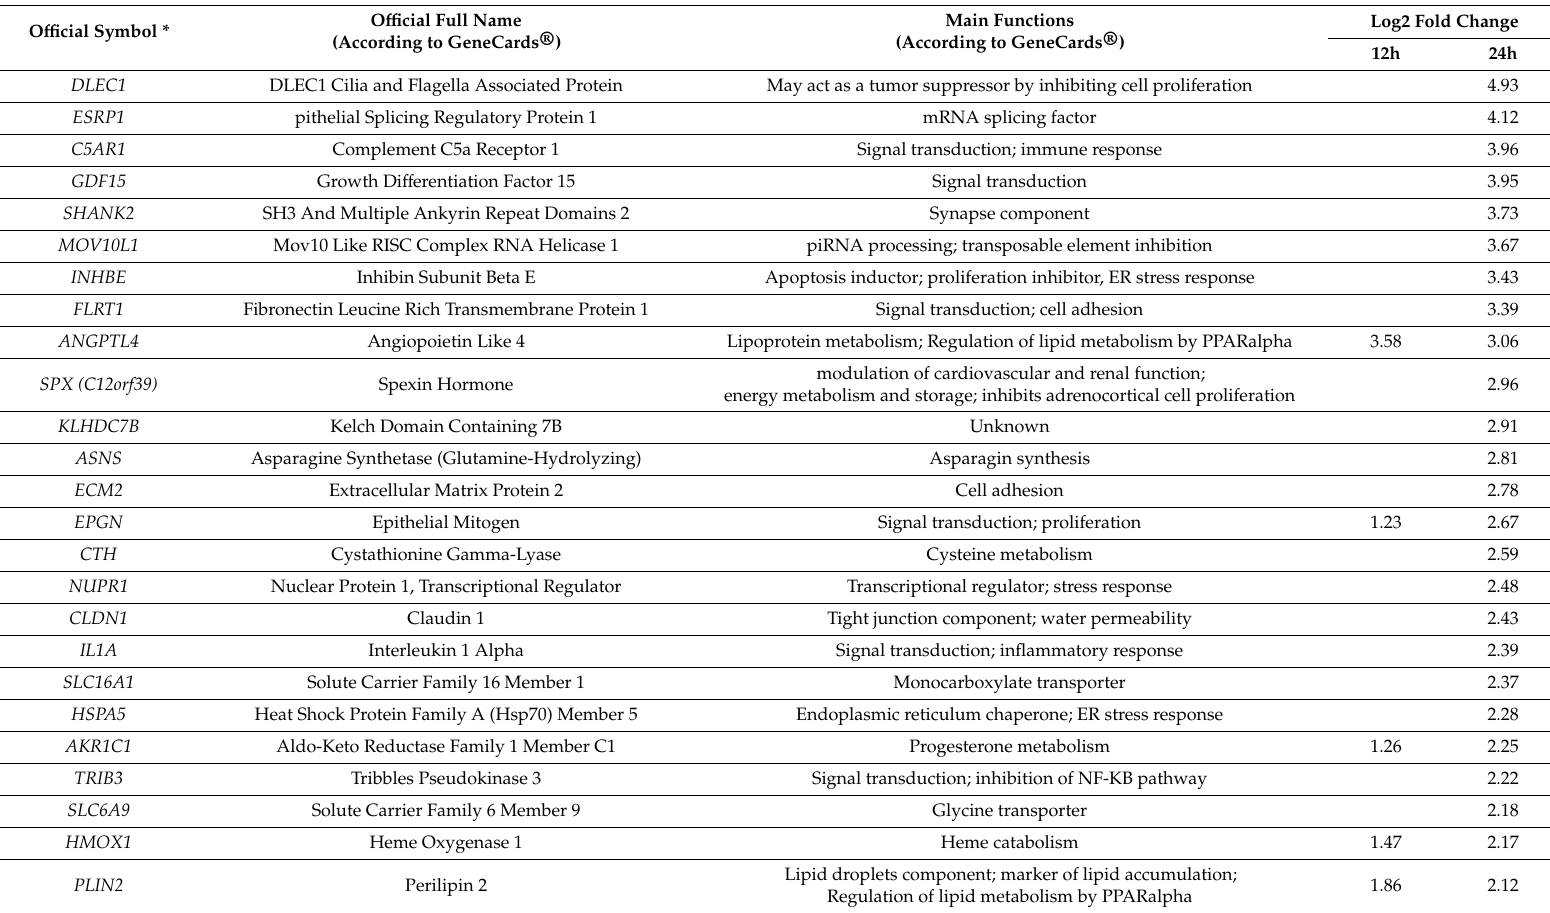
Table 1. Top 25 of DHA-upregulated genes (with the exception of pseudogenes and LncRNA). O ffi cial Symbol